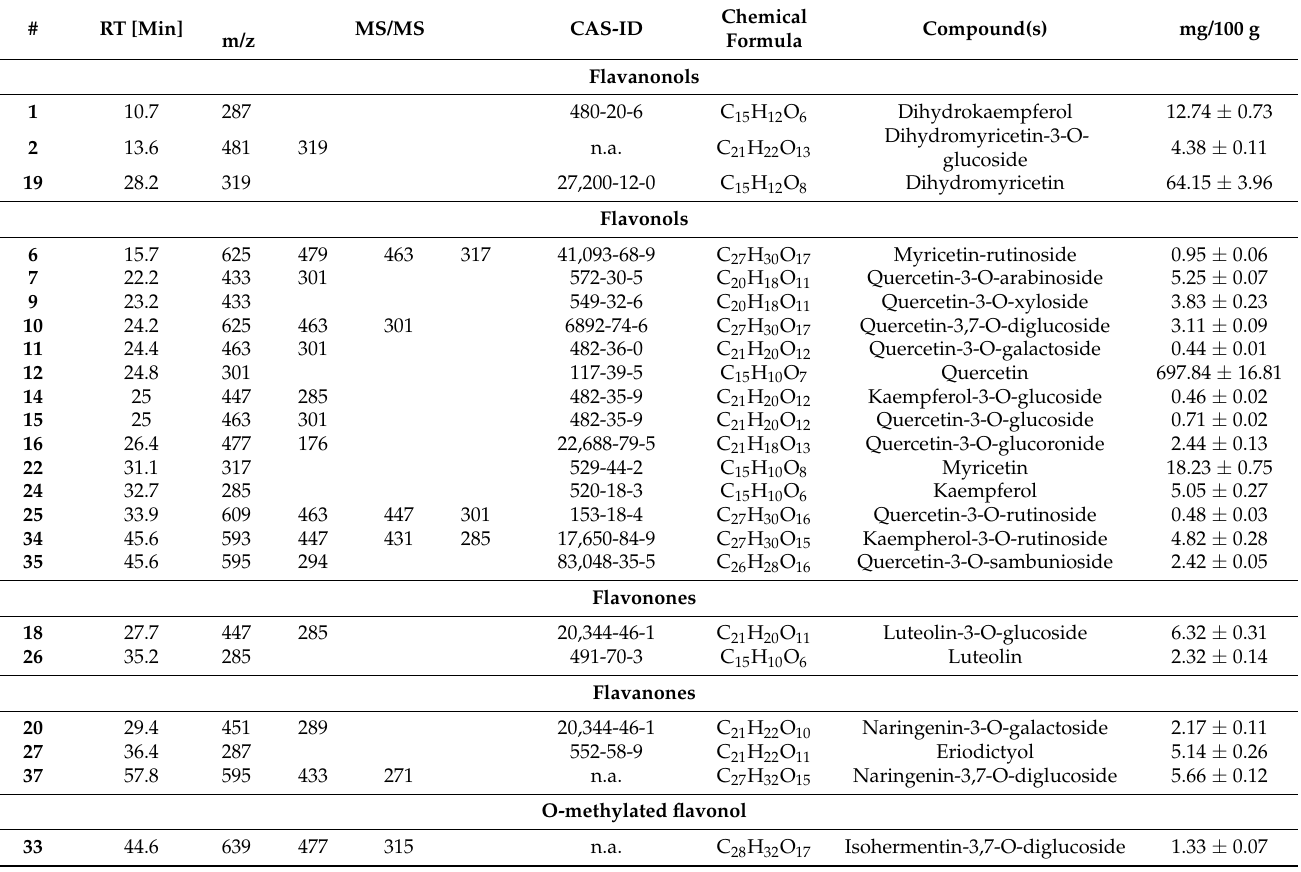
Table 1. Qualitative and quantitative phytochemical characterization of flavanonols, flavonols, flavonones, flavanones, and o-methylated flavonols in the WRSP extract. Results (mg per 100 g of FW) are expressed as mean ± SD of three different